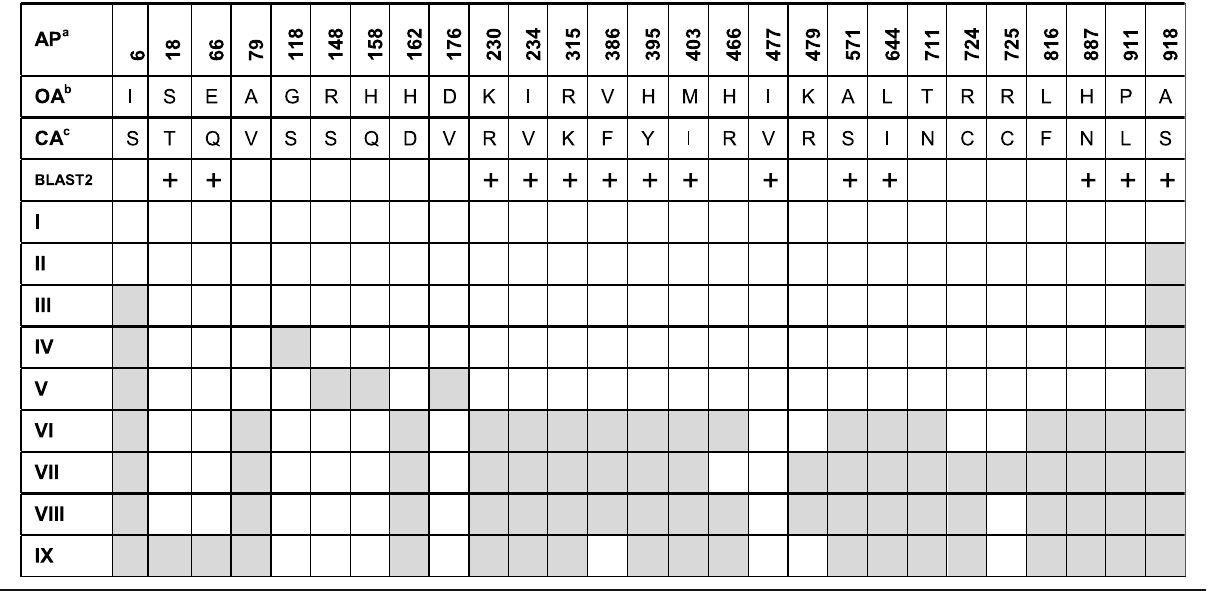
Table 1 Schematic representation of positional changes along with the amino acid sequences of 47 Sri Lankan rice accessions compared to wPi-ta ( Tetep ). The + sign shows the functional similarities of the amino acids and the empty boxes depict the